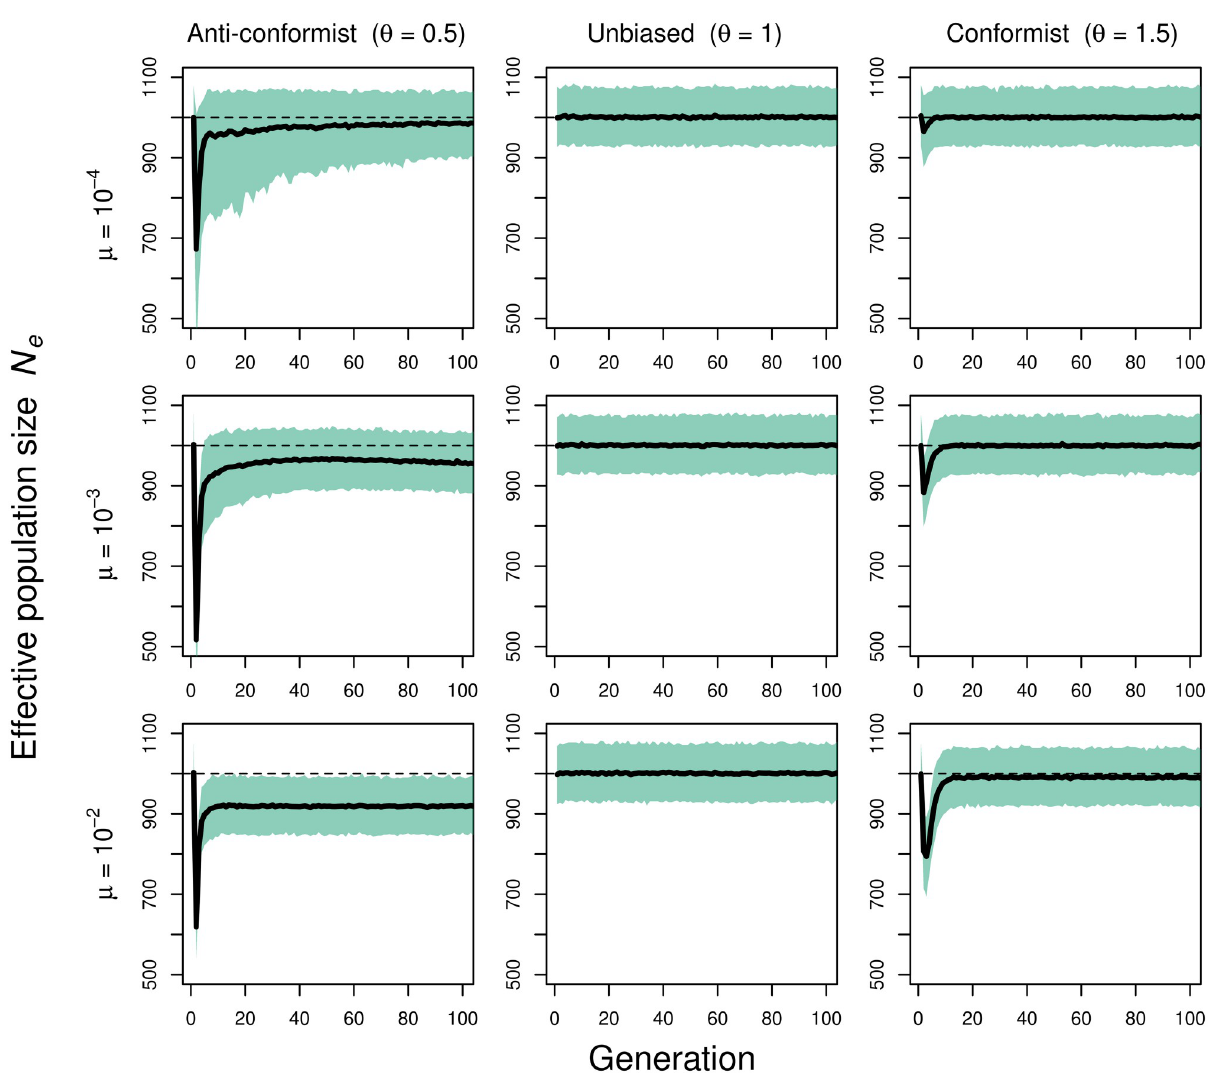
Fig 3. Frequency-dependent transmission. Effective population size (including 90% PIs) for anti-conformist ( θ = 0.5; left), unbiased ( θ = 1; center) and conformist transmission ( θ = 1.5; right) and different innovation rates μ . Plots show trajectories for 100 generations after switch in transmission mode (1000 independent simulations; N =